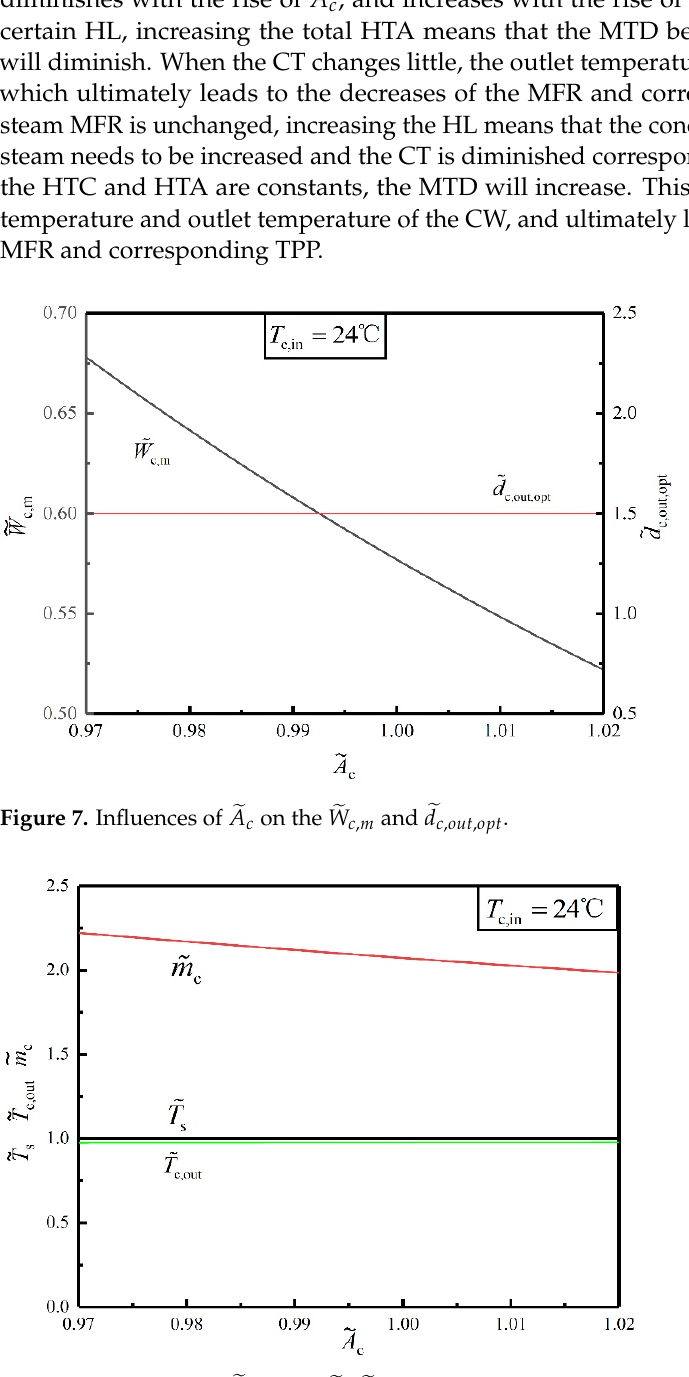
m . Figure 8. Influences of (cid:101) A c on the (cid:101) T s , (cid:101) T c , out and (cid:101) m c m . c c